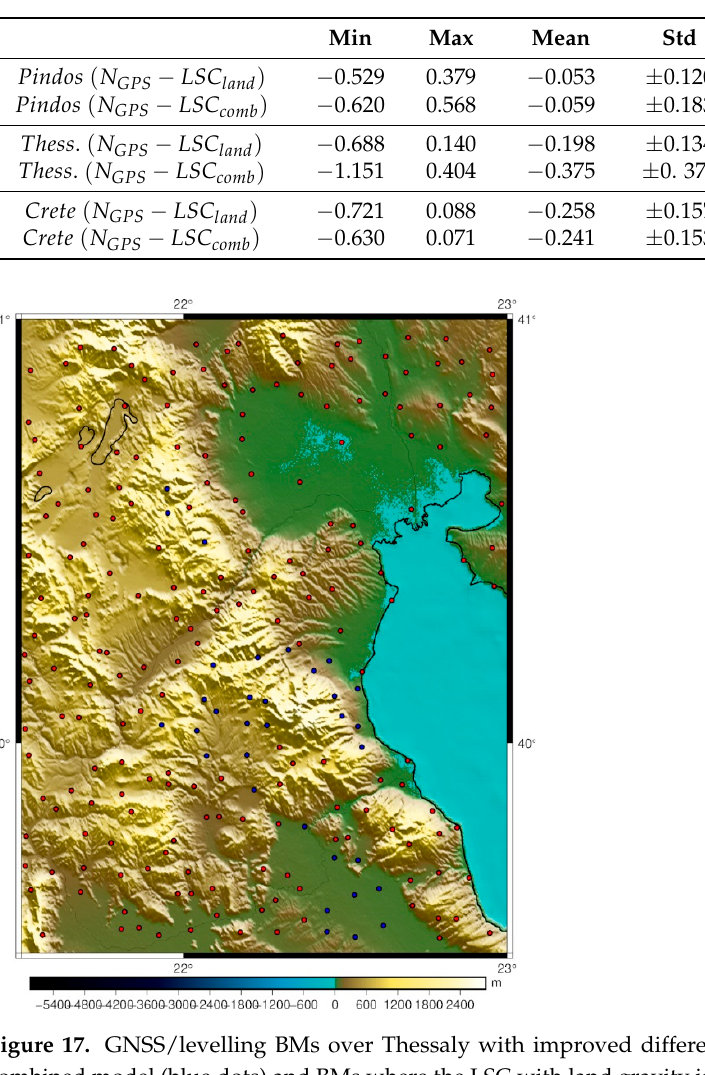
Table 9. Statistics of geoid height differences between the GNSS/leveling data and the LSC models with number of BMs with improved differences compared to terrestrial gravity only model. Unit: (m).